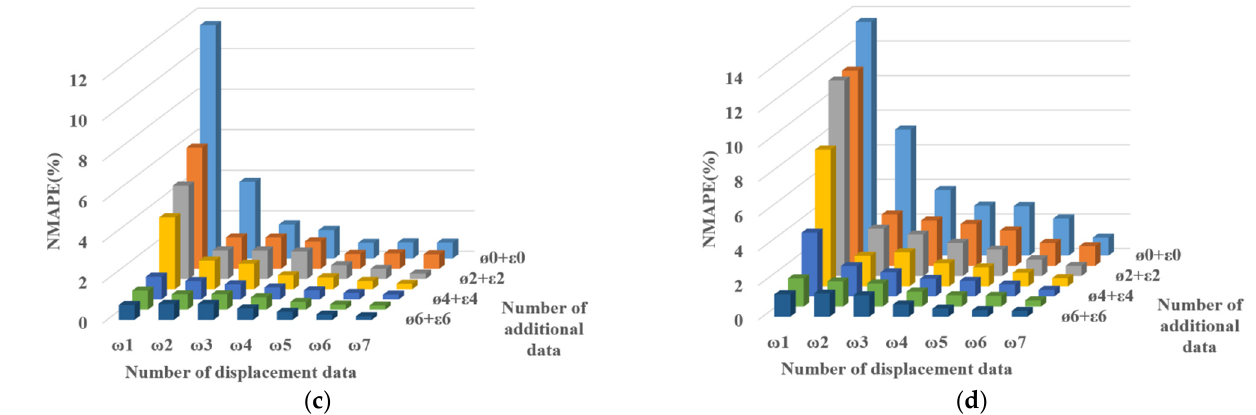
Figure 7. NMAPE of the EDS according to the number of measurement data. ( a ) TM1; ( b ) TM2; ( c ) TM3; ( d ) TM4.